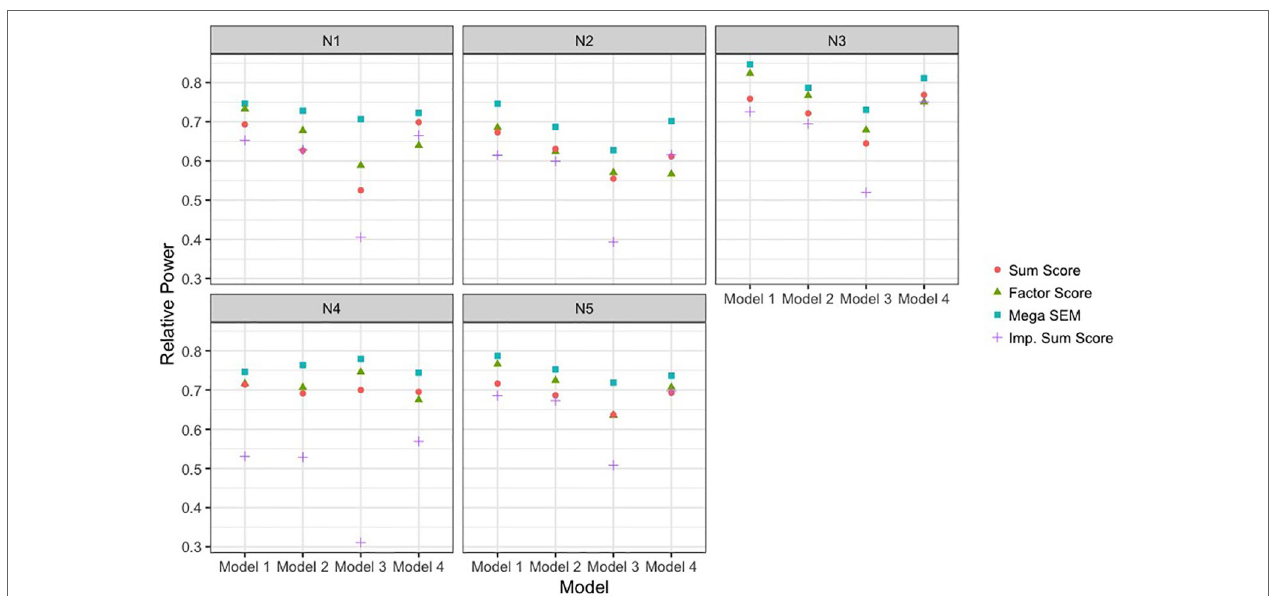
FIGUre 3 | Power to detect single-nucleotide polymorphism effect of each analysis approach relative to complete data power. Results are presented across the different data-generating models and the different sample size conditions detailed in Table 1 . The analysis approaches were sum score meta-analysis, factor score meta-analysis, mega-analysis with the bi-factor integration mode, and multiple imputation of the missing items. SEM, structural equation modeling; Imp.,